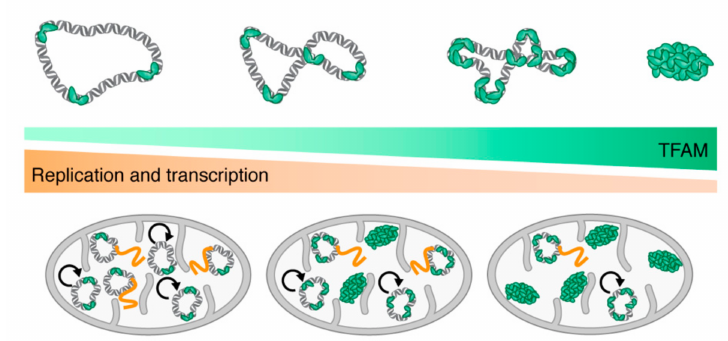
Figure 3. Regulatory role of TFAM in DNA transactions. Model of how TFAM levels and DNA compaction (upper panel) regulate replication and transcription in mitochondria (lower